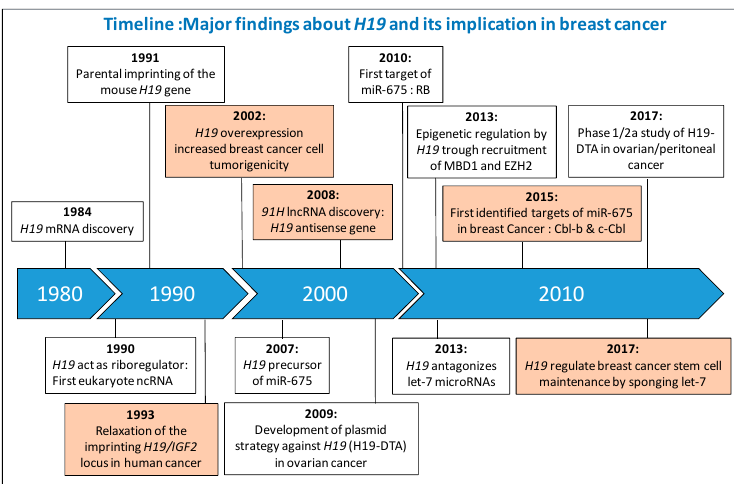
Figure 1. Major finding about H19 and its implication in breast cancer. Information concerning the implication of H19 in breast cancer are colored orange. IGF2, Insulin-like Growth Factor 2; lncRNA, Long Non-Coding RNA; RB, Retinoblastoma; MBD1, Methyl-CpG Binding Domain, EZH2, Enhancer of Zeste Homolog 2; Cbl, Casitas B-lineage Lymphoma; H19-DTA, Plasmid encoding the A chain of diphtheria toxin (DT-A) driven by the regulatory sequences of human H19 .